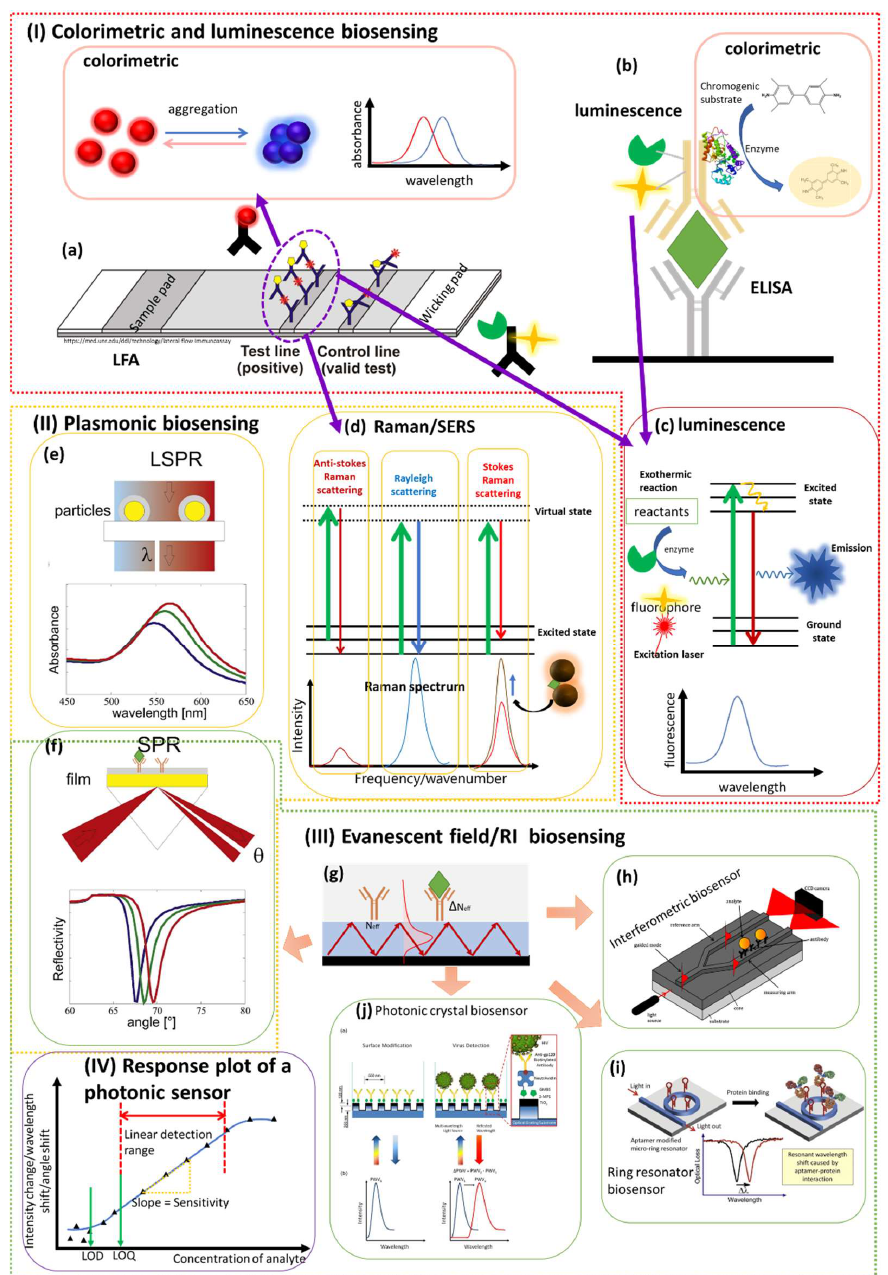
Figure 2. Photonic biosensors based on different techniques . ( I ) colorimetric and luminescence biosensors: ( a ) working principle of colorimetric biosensor based on aggregation on a LFA platform; ( b ) working principle of colorimetric biosensor based on chromogenic substrate in ELISA; ( c ) basic principle of luminescence process driven by chemical reaction (chemiluminescence, left top) and photon excitation (fluorescence, left bottom). ( II ) Plasmonic biosensors: ( d ) basic principle of Raman scattering and SERS; ( e ) working principle of LSPR; ( f ) working principle of SPR. ( III ) evanescent field/ refractive index-based biosensors: ( g ) mechanism of evanescent filed sensing; schematics of working principle of ( h ) interferometric biosensor, ( i ) ring resonator biosensor, and ( j ) photonic crystal-based biosensor. ( e , f ) are adapted from ref. [103] with permission from Elsevier, Copyright (2016). ( h ) is adapted from ref. [104] with permission from Universiteit Twente. ( i ) is adapted from ref. [105] with permission from Elsevier, Copyright (2012). ( j ) is adapted from ref. [106] with permission from Springer Nature, Scientific Reports, Copyright (2014). ( IV ) A typical calibration plot of a photonic